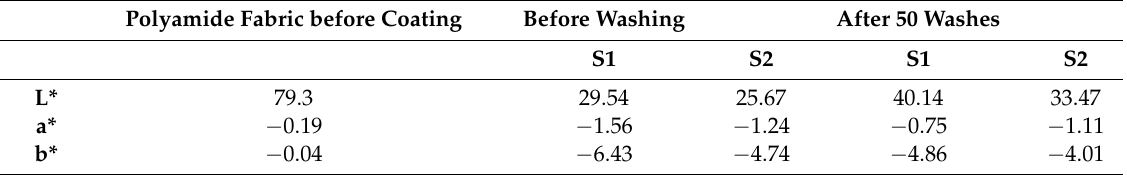
Table 3. CIELAB values for polyamide fabric and electrodes coated by the two PEDOT:PSS solutions. Polyamide Fabric before Coating Before Washing After 50 Washes S1 S2